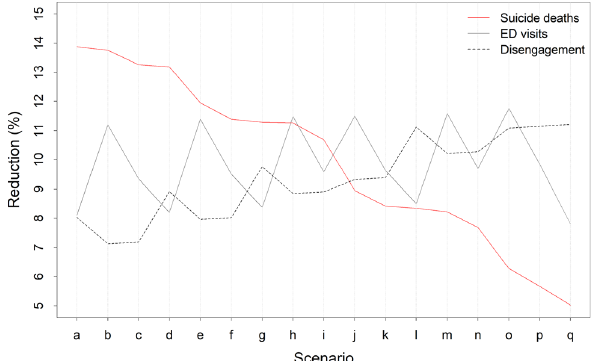
Figure 5. Projected reductions (%, relative to the baseline scenario) in total numbers of suicides, mental health- related emergency department (ED) presentations, and patients disengaging from services across the Hunter New England and Central Coast Primary Health Network over the period 2021–2031. Intervention scenarios are ordered so that the number of suicides prevented decreases from left to right (see Table 2 for intervention scenario